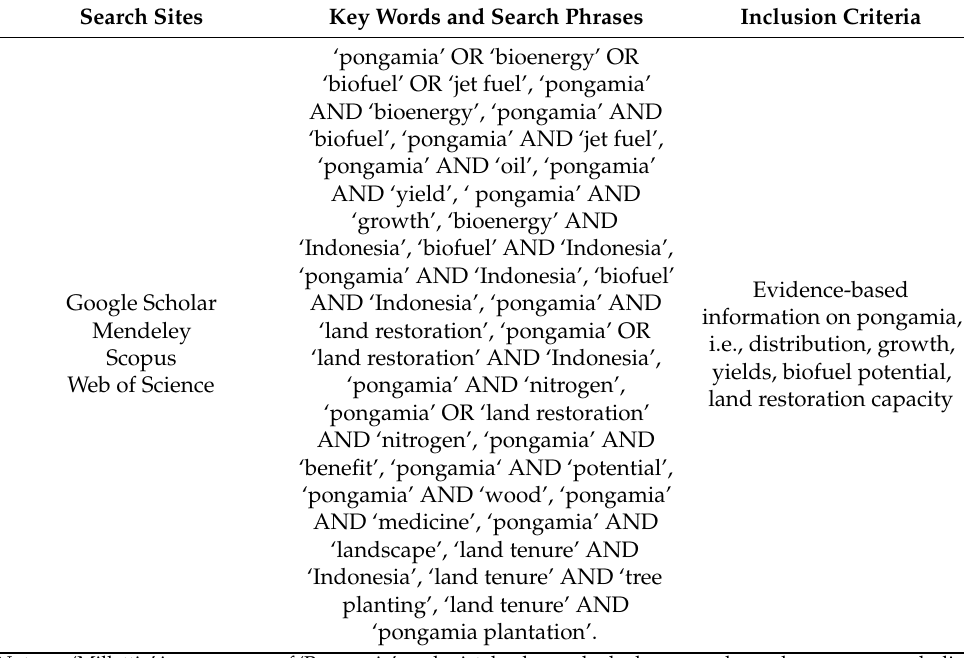
Table 1. Search sites, key words and inclusion criteria to generate targeted information from the literature review used in this